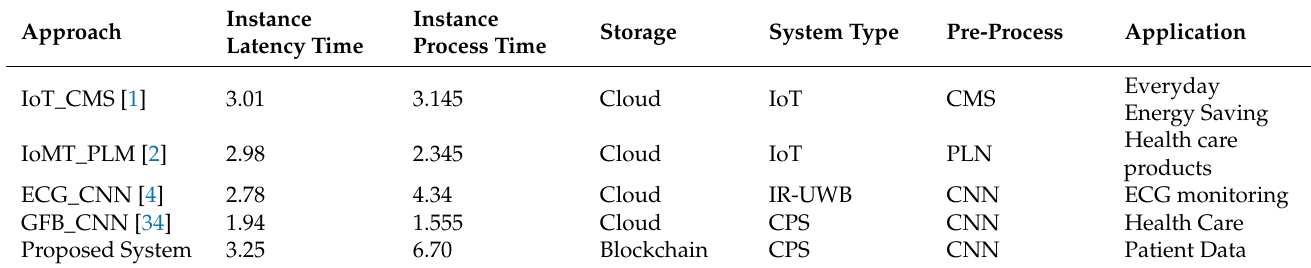
Table 6. Comparison with the existing system by specified characteristics.